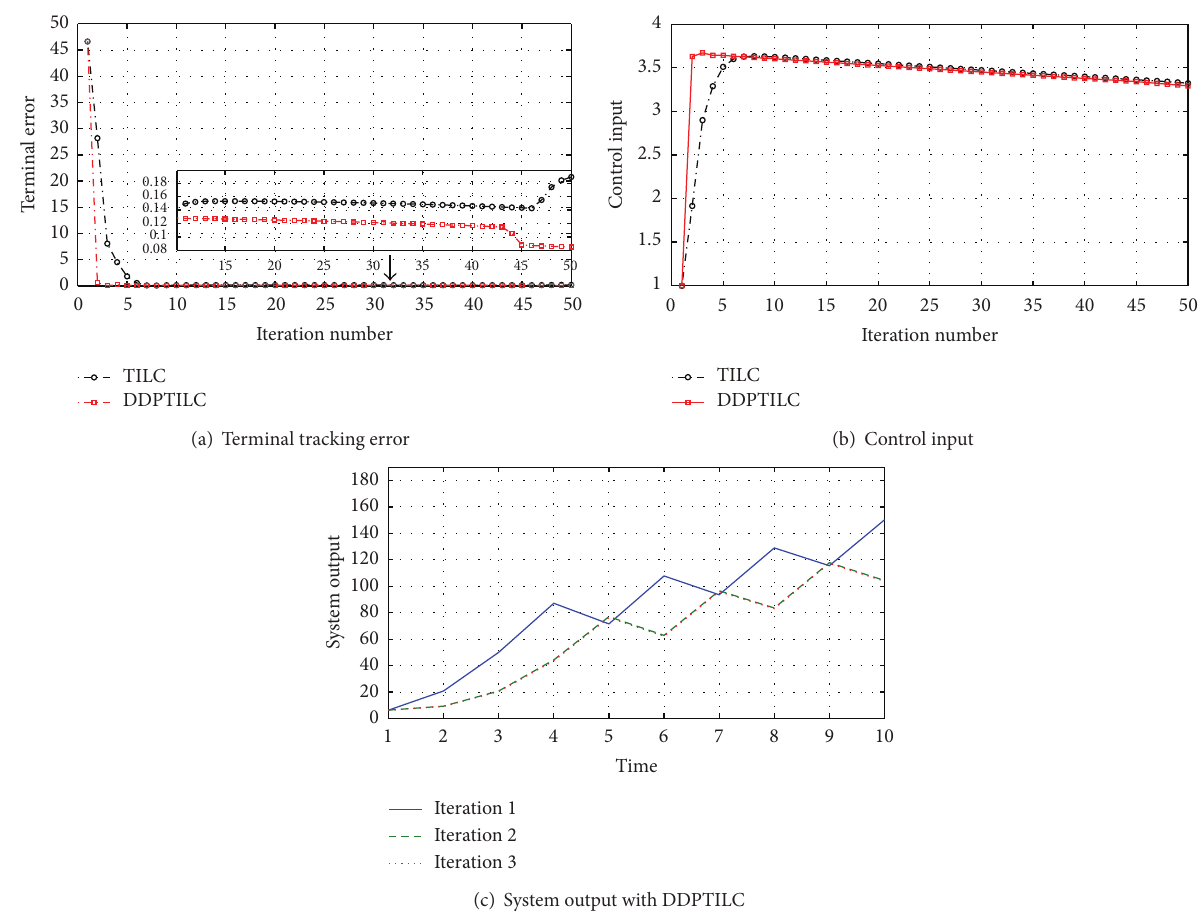
Figure 2: Simulation comparison between TILC and DDPTILC (Case